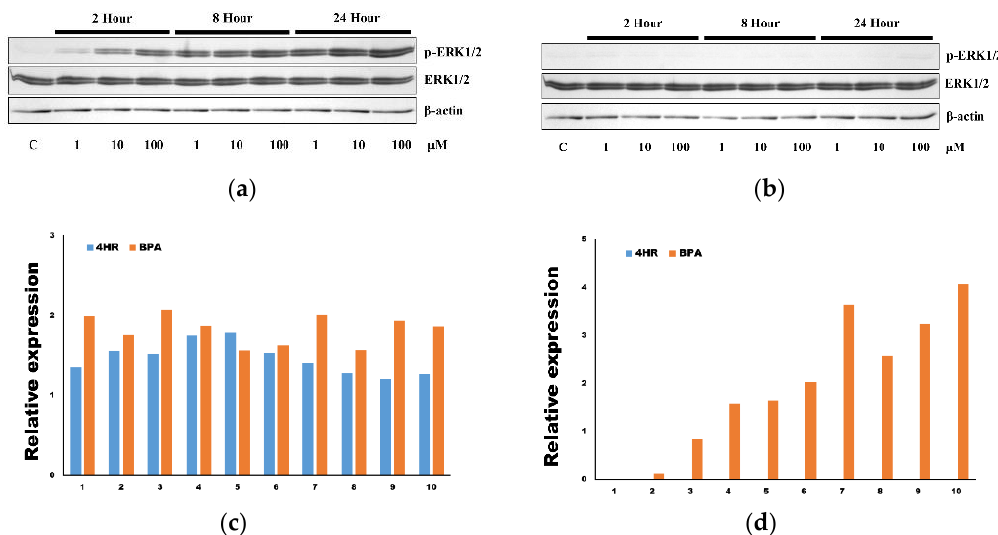
Figure 3. The expression of extracellular signal-regulated kinase-1/-2 (ERK1/2) and phosphorylated p-ERK1/2 (p-ERK1/2). ( a ) The application of BPA (1 to 100 μM) to MCF -7 cells increased the expression of p-ERK1/2. ( b ) The application of 4HR (1 to 100 μM) to MCF -7 cells showed no change of p-ERK1/2 expression. ( c ) Relative protein expression of ERK1/2 to β -actin. The application of BPA slightly increased relative expression level of ERK1/2 compared to that of 4HR. However, the difference between groups seemed to be not significant. ( d ) Relative protein expression of p-ERK1/2 to β -actin. The application of BPA increased relative expression level of p-ERK1/2 compared to that of 4HR. In the case of 4HR, p-ERK1/2 was barely detected. Full length blots were available in Supplementary Figures 3 and 4.